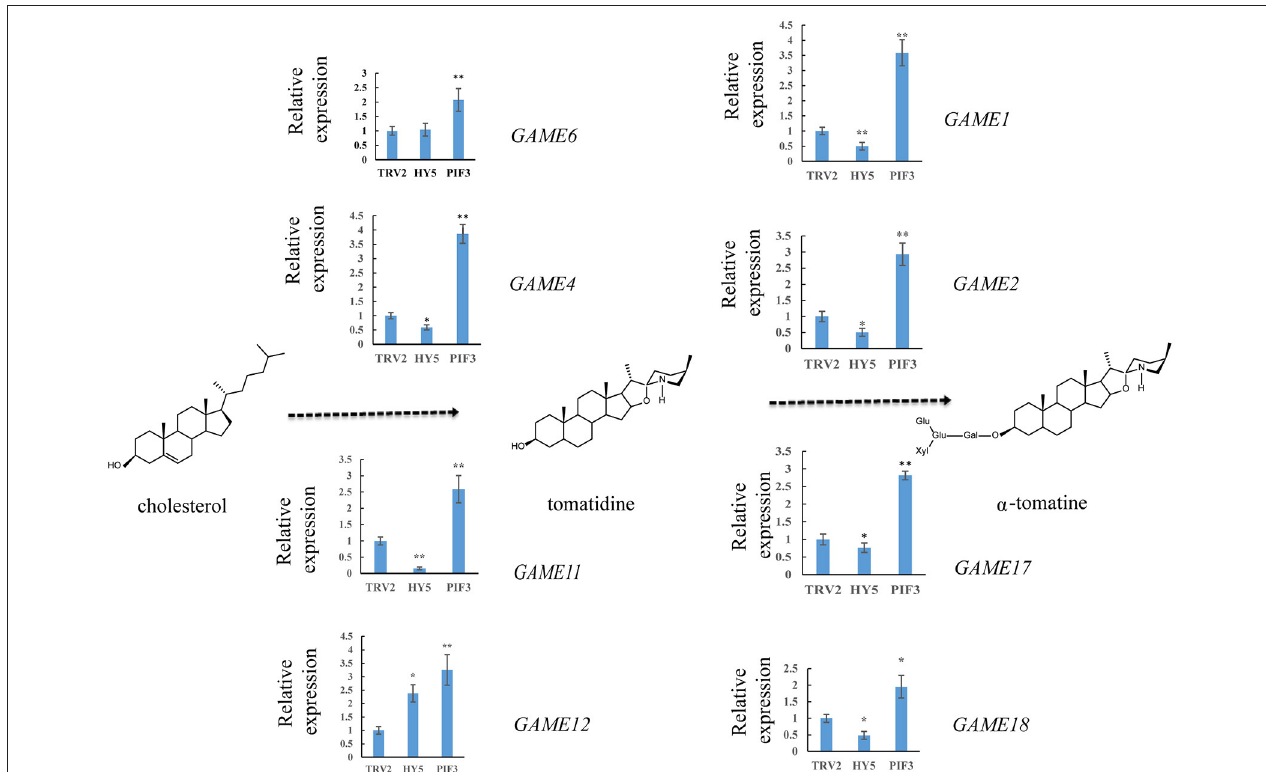
FIGURE 3 | Relative expression levels of glycoalkaloid pathway genes in leaves following infiltration with different constructs. A schematic view of the SGA biosynthetic pathways. Dashed arrows represent multiple biosynthetic reactions. Graphs next to each gene name show expression levels determined by qRT-PCR, normalized to the Actin housekeeping gene and to the mock-infected control. Data are mean ± standard deviation of three biological replicates. Asterisks indicate a significant difference from the control according to Student’s t -test (** P < 0.01 and * P < 0.05).